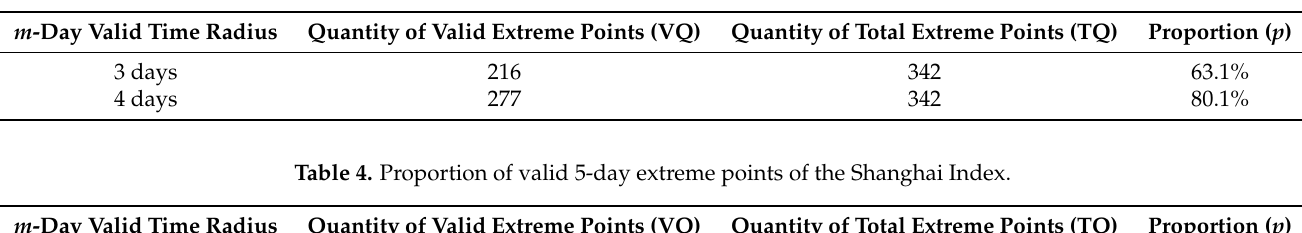
Table 3. Proportion of valid 10-day extreme points of the Shanghai Index.